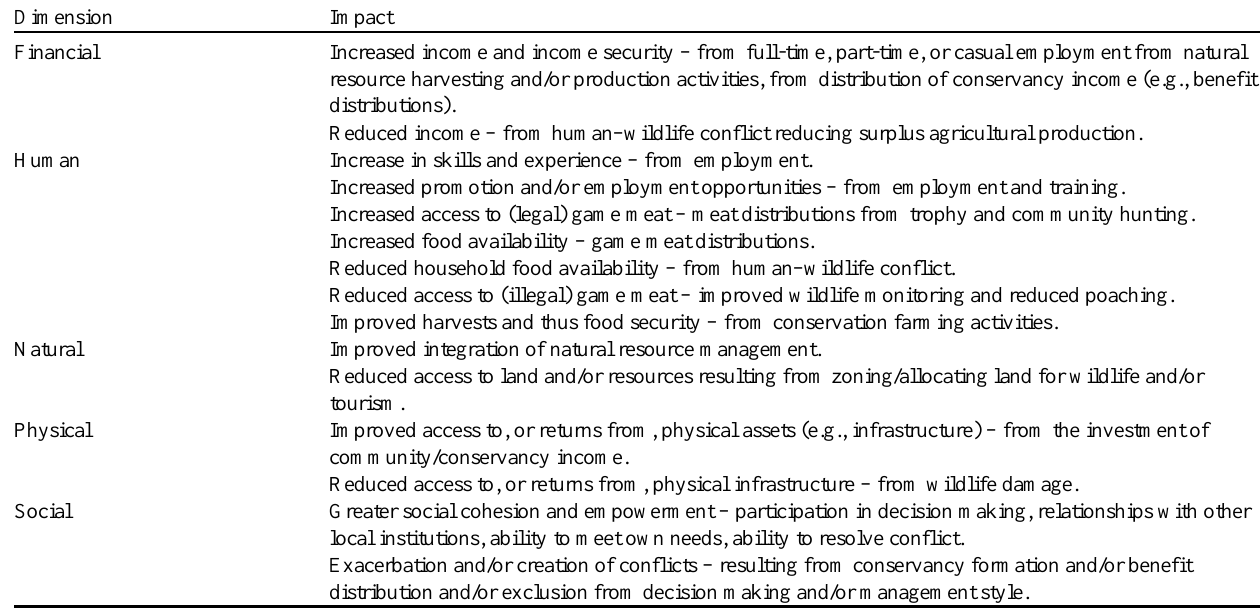
Table 1 . Potential impacts on multiple dimensions of poverty arising from community based natural resource management activities. Source: adapted from Suich (2010 a ). Dimension Impact